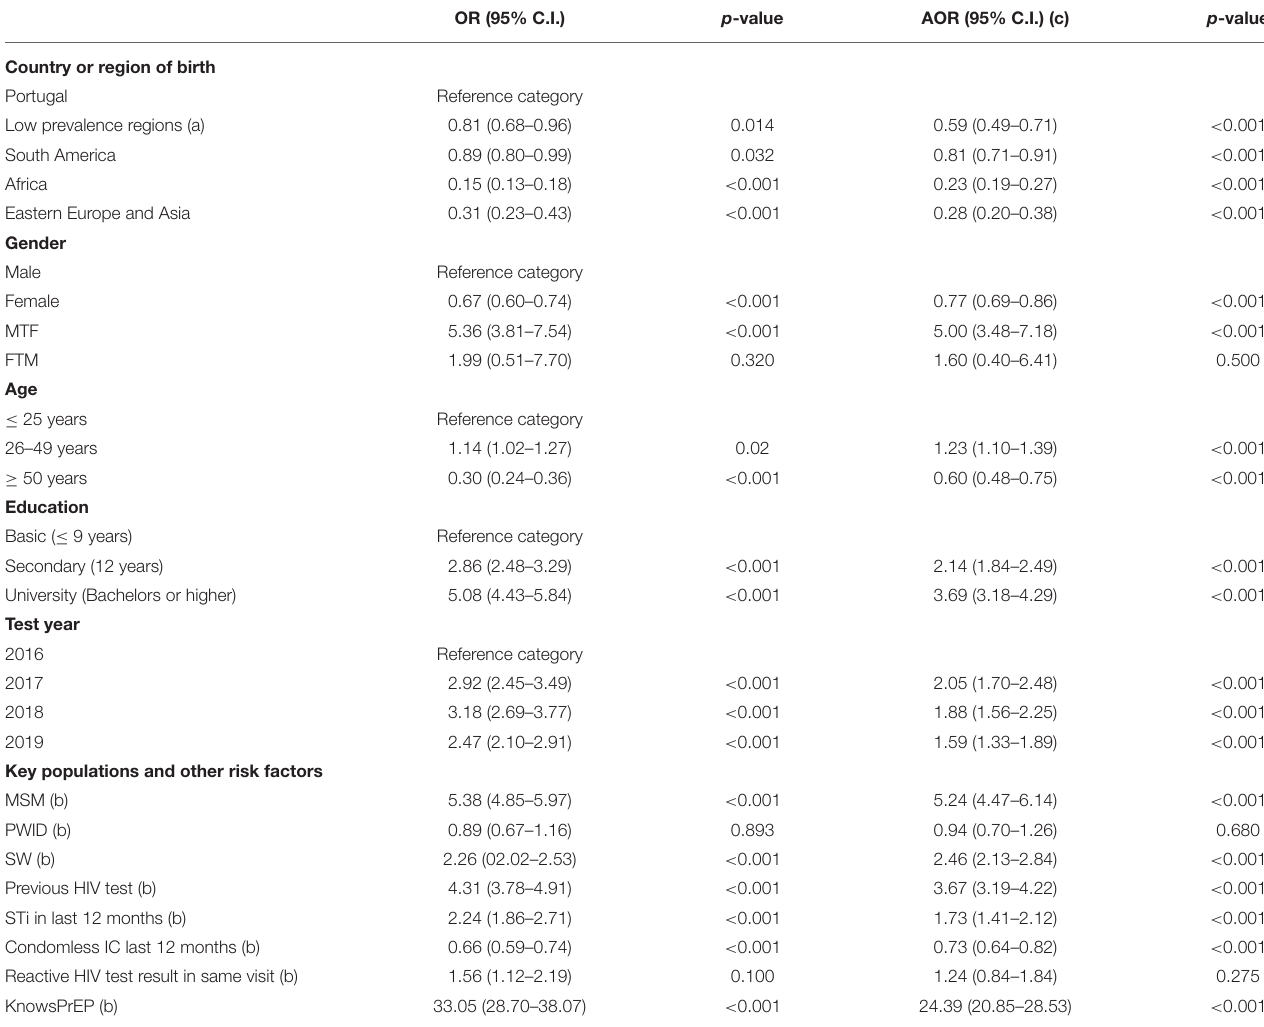
TABLE 4 | Factors associated with knowledge of